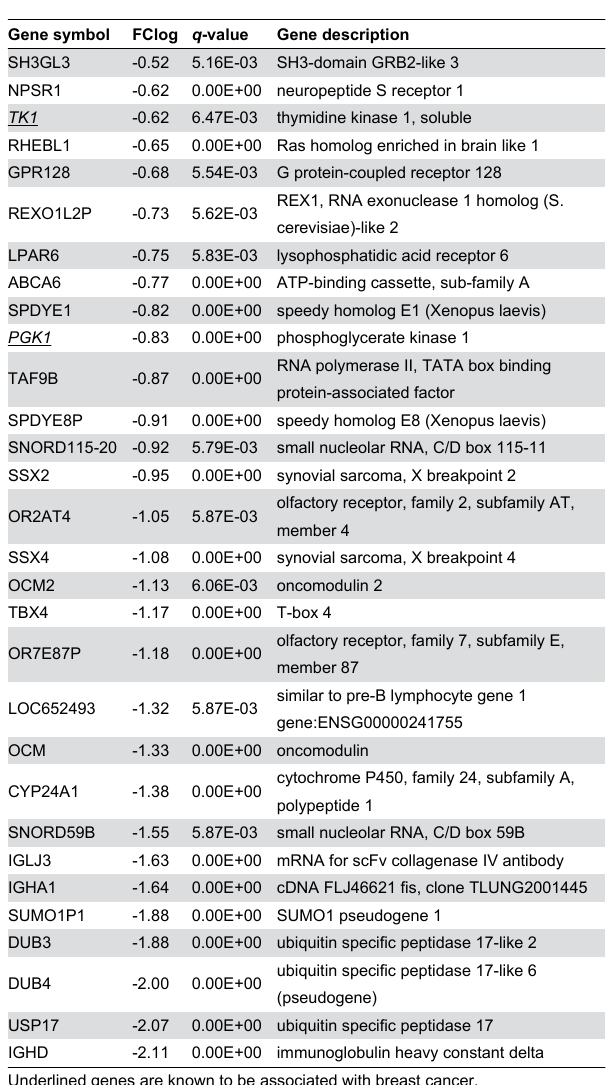
Table 3. 30 under-expressed genes with lowest q